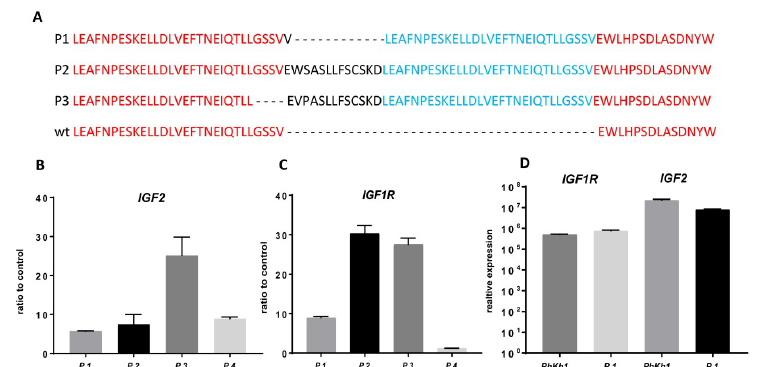
Figure 2. IGF2 and IGF1R are highly expressed in high-grade neuroepithelial tumor with BCOR alteration (HGNET-BCOR). ( A ) Protein sequence of the BCOR allele of patients P1, P2, and P3 carrying BCOR internal tandem duplications (ITD) compared to wild-type (wt) BCOR . ( B , C ) qRT-PCR analysis was performed using primers specific for IGF2 and IGF1R . Data are shown as the fold change of the expression in the tumor tissues of three HGNET-BCOR patients (P1, P2, and P3) and one hepatoblastoma patient (P4) with respect to the expression in normal liver (control). Expression analysis was done in triplicate on RNA extracted from formalin-fixed paraffin-embedded (FFPE) material. ( D ) qRT-PCR analysis was performed using primers specific for IGF2 and IGF1R , with RNA extracted from PhKh1 cells or frozen material from the metastasis of origin of PhKh1 cells. After normalization to the expression of the housekeeping gene HPRT1 , the relative quantification value was expressed as 2−ΔΔCt. The calibrator was calculated as the maximal number of cycles used in the PCR (40) minus the mean of the HPRT1 Ct values, resulting in a value of 19.